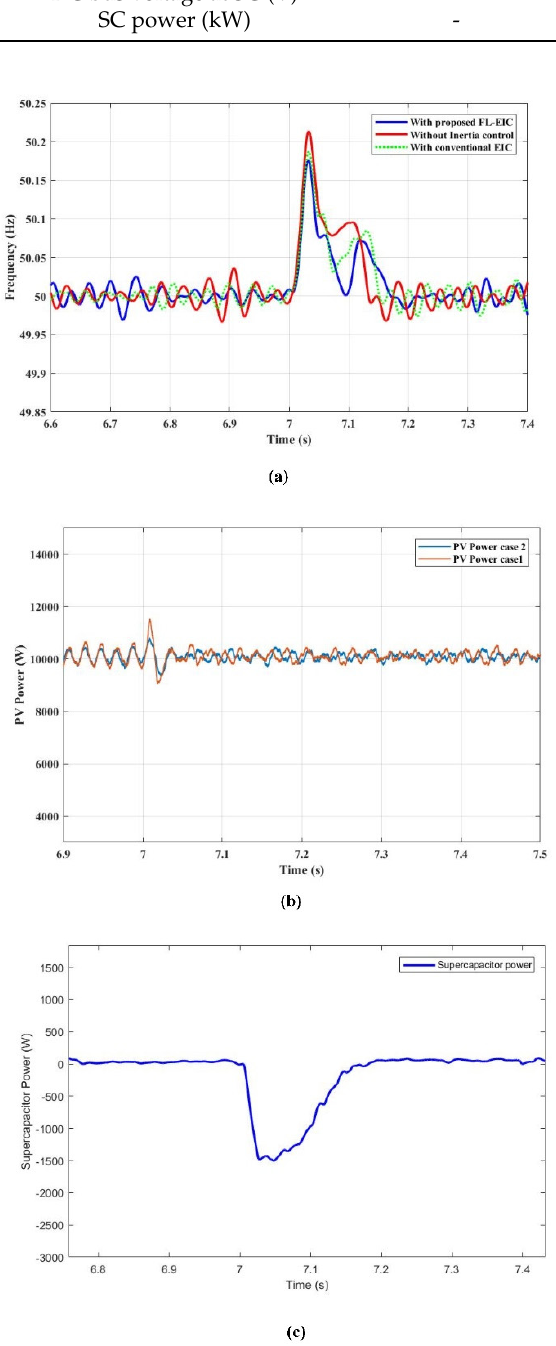
Figure 14. Over-frequency event ( a ) Frequency, ( b ) PV power, ( c ) supercapacitor power.